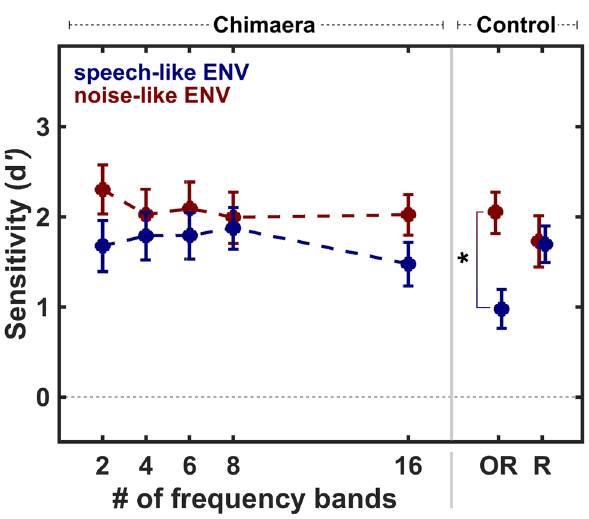
Figure 2. Sensitivity to sound motion across conditions for each ENV type. Sensitivity scores ( d’ ; mean ± sem) are plotted as a function of chimaera and control conditions, with ENV type indicated by color. Higher scores indicate better discriminability. Across chimaera conditions, listeners were significantly more sensitive to sound motion for stimuli with noise-like ENVs (red) compared to speech-like ENVs (blue). In control conditions, original stimuli did not differ from chimaera stimuli, but listeners were significantly less sensitive to sound motion when stimuli were speech (OR S ) compared to SMN (OR SMN